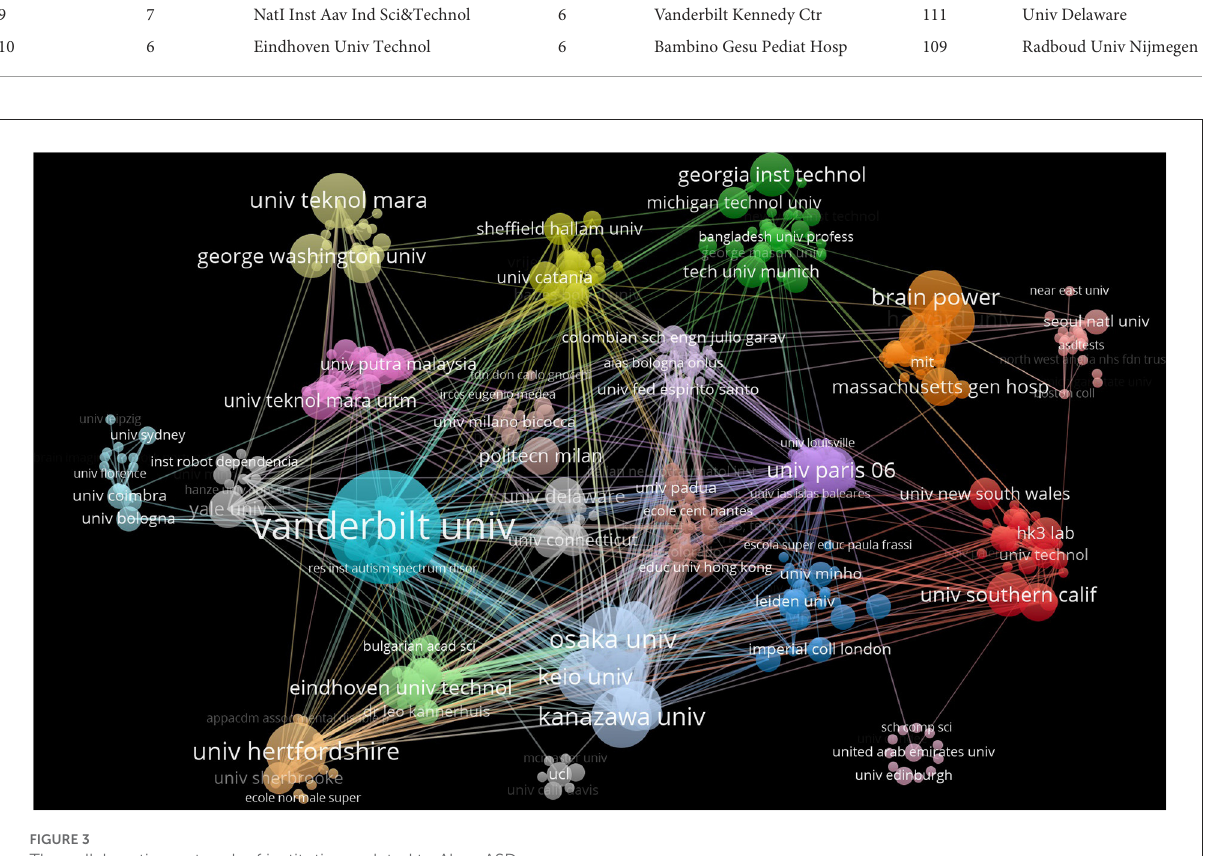
FIGURE3 The collaboration network of institutions related to Al on